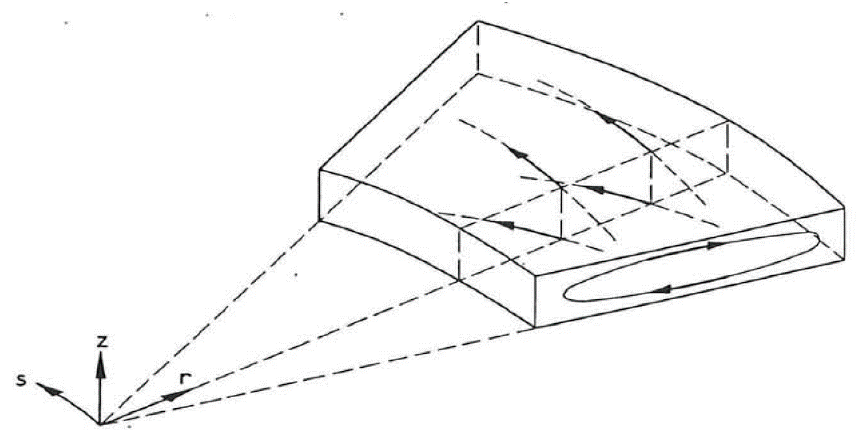
Figure 1. The mechanism of secondary flow (Jansen, 1994) [27]. The main flow of the curved channel is affected by the redistribution of the velocity. The velocity increases near the outer bank of the channel and decreases near the inner bank of the channel (De Vriend, 1980) [4]. As the river enters the bend, the flow particles are affected by the acceleration due to centrifugal force. Accordingly, the flow particles tend to move towards the external wall of the river. Then, an increase in the water level occurs near the outside wall and decreases near the inside wall. Non-uniform pressure distribution is generated in the cross-section due to the slope of the free surface. This pressure increases near the external wall. Due to the difference between the small vertical accelerations and the high gravitational acceleration, there is a distribution of the hydrostatic pressure over the vertical. Subsequently, there is approximate equality in the pressure gradient in the radial direction over the vertical. Thus, the magnitude of the longitudinal velocities is equal at all points in the vertical direction and the centrifugal accelerations are completely counterbalanced by the centripetal acceleration. Due to the viscosity forces, there is a non-uniform distribution of the longitudinal velocity, which, in turn, causes a non-uniform distribution of the centrifugal acceleration. Accordingly, the velocity and the centrifugal acceleration increase near the flow surface and decrease near the bottom. The helical movement that is vertical to the main flow occurs because of the imbalance between the separate points in a vertical direction as shown in Figure 2. The movement of the helical path depends on the centrifugal acceleration, which means it is directed towards the outer bank at the upper part of the river as the centrifugal acceleration increases and towards the inner bank at the lower part of the river as the centrifugal acceleration decreases at this area. As the flow enters the bend, the free surface slope must be built up. Therefore, there is a negative pressure gradient near the internal wall and another positive pressure gradient close to the external wall (Jongbloed, 1996) [28].